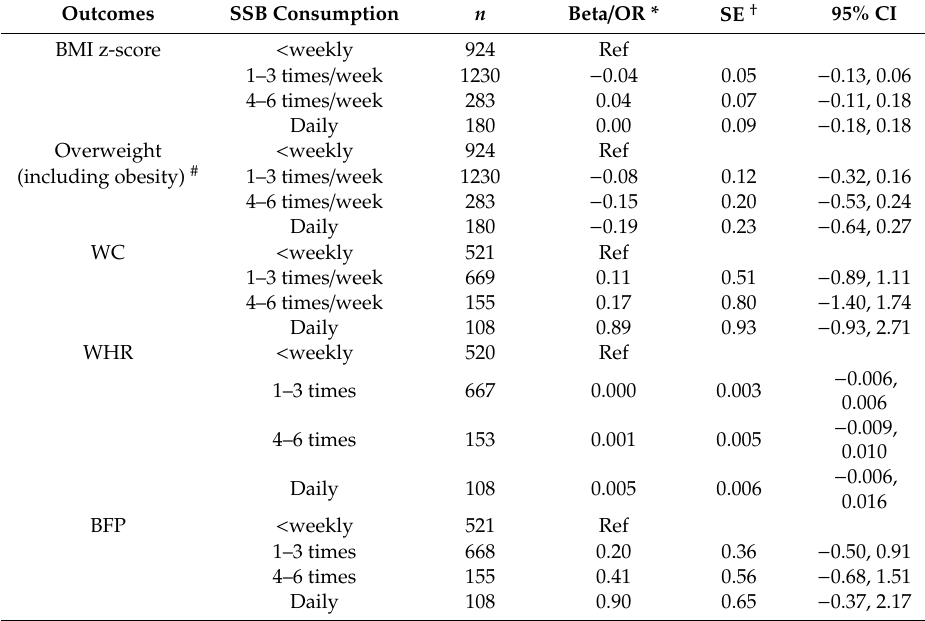
Daily − 0.37, 2.17 BFP, body fat percentage; BMI: body mass index; SE: standard error; CI: confidence interval; OR: odds ratio; SSB, sugar-sweetened beverage; WC, waist circumference; WHR, waist-to-hip ratio. Values for BMI z-score and overweight were derived from GEE models, whereas values for WC, WHR and BFP were derived from multivariable linear regression models. All models were adjusted for age, sex, maternal age at birth, maternal birthplace, parental highest education level, parental highest occupation, household income per head, and interaction of maternal birthplace with parental highest education level. # Reference: normal weight. * Beta for BMI z-score, WC, WHR and BFP and OR for overweight (including obesity). † Standard error of logOR for overweight (including